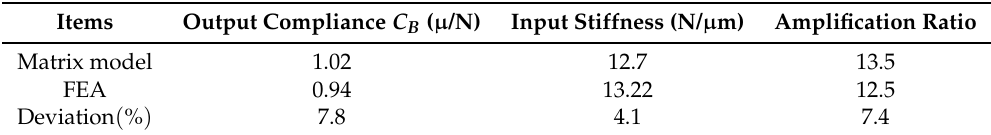
Table 5. The performance comparison of the proposed